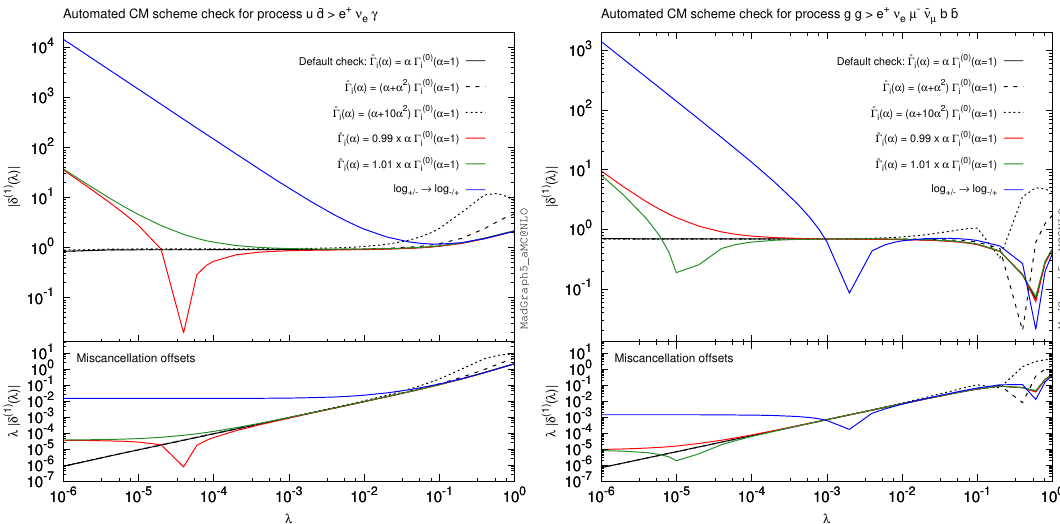
Figure 16. Tests of the CM-scheme implementation performed by MG5 aMC , for the u (cid:22) d ! e + (cid:23) e (cid:13) (left panel) and gg ! e + (cid:23) e e (cid:0) (cid:22) (cid:23) e b (cid:22) b (right panel) processes, with di(cid:11)erent choices for the widths